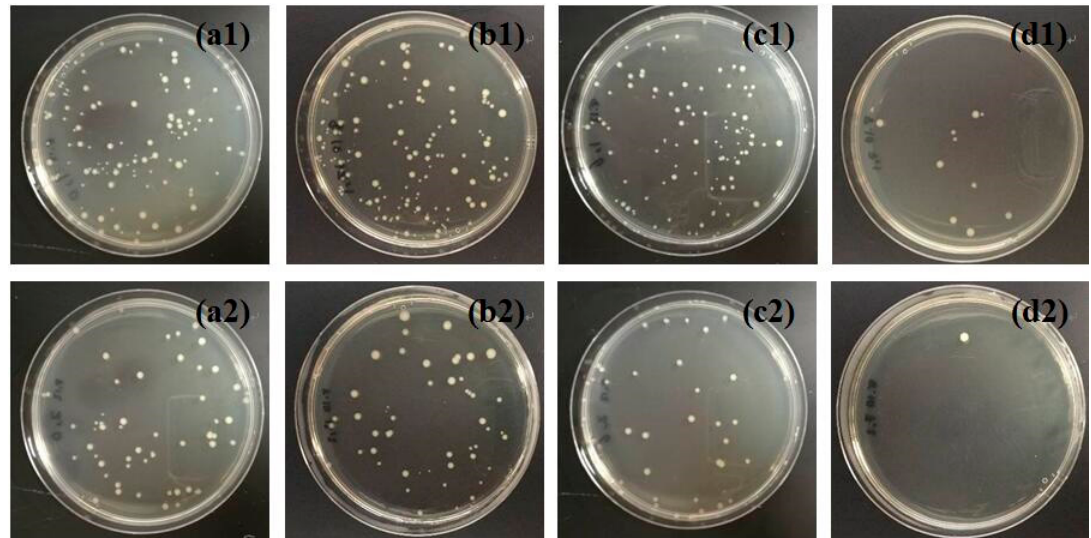
Figure 7. Dark-condition antibacterial results for ( a1 ) control; ( b1 ) cellulose; ( c1 ) TiO 2 /cellulose composite film; and ( d1 ) Ag/TiO 2 /cellulose composite film (Ag/TiO 2 molar ratios of 5.0%). Ultra-violet (UV)-condition antibacterial results for ( a2 ) control; ( b2 ) cellulose; ( c2 ) TiO 2 /cellulose composite film; and ( d2 ) Ag/TiO 2 /cellulose composite film (Ag/TiO 2 molar ratios of 5.0%).